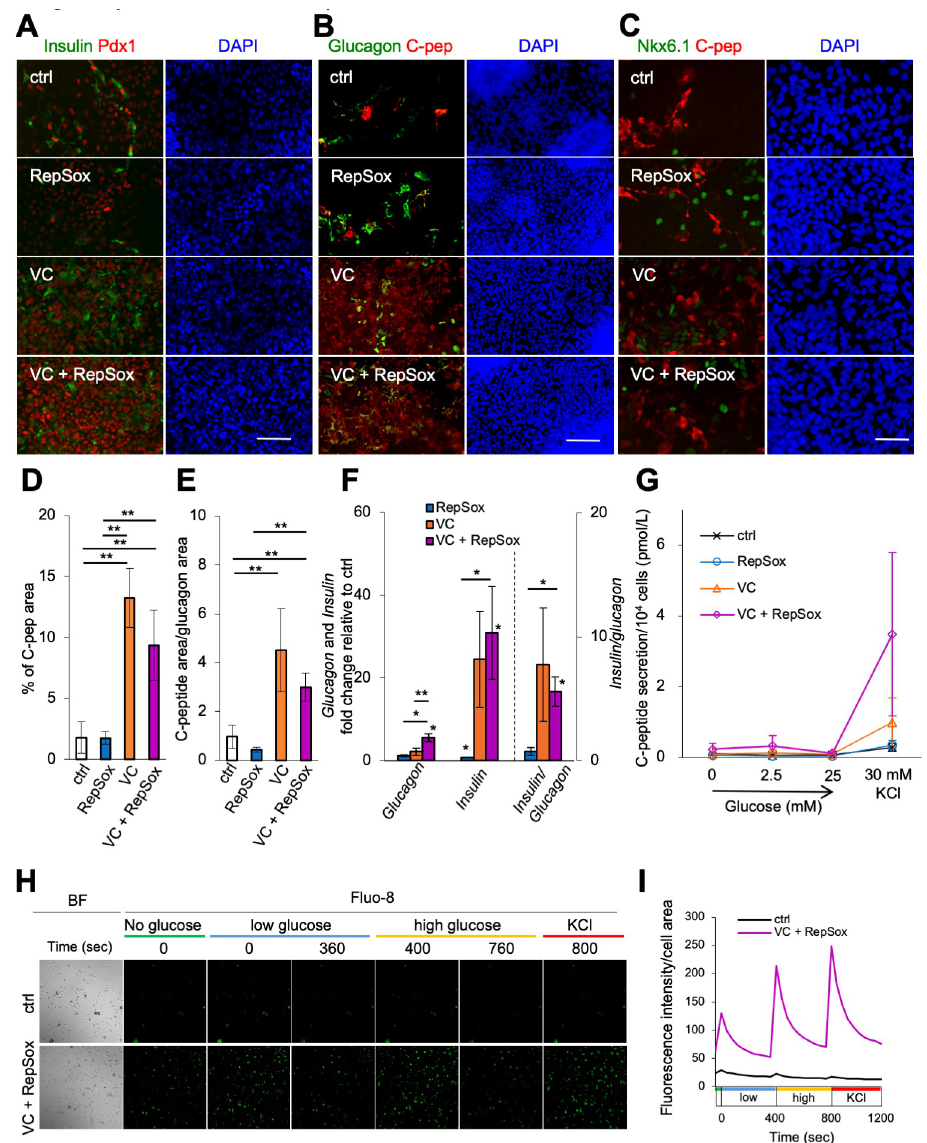
Fig 4. Vitamin C addition increased the number of insulin-producing cells (stage 4). ( A-C ) IHC. The expression of insulin (green) and Pdx1 (red) ( A ). The expression of glucagon (green) and C-peptide (red) ( B ). The expression of Nkx6.1 (green) and C-peptide (red) ( C ). DAPI staining shown in blue. Scale bars: 100 μ m ( A , B ), 50 μ m ( C ). ( D ) The percentage of the cell area expressing C-peptide in the monolayer region, corresponding to B (n = 5, including one biological and five technical replicates). � p < 0.05, �� p < 0.01; Welch’s t -test. ( E ) The C-peptide-positive cell area divided by glucagon-positive area. Glucagon-positive cell areas in a certain region of the monolayer cells were measured using B (n = 5, including one biological and five technical replicates). Control, white; RepSox, blue; VC, orange; VC + RepSox, magenta. � p < 0.05, �� p < 0.01; Welch’s t -test. ( F ) Fold change of the expression levels of the indicated genes and insulin/glucagon compared with the control at stage 4 by qRT-PCR (n = 3 biological replicates per group). RepSox, blue; VC, orange; VC + RepSox, magenta. Asterisks represent statistical significance. � p < 0.05, �� p < 0.01; paired t -test. The asterisk on the bar graph shows a significant difference compared with the control. ( G ) The amount of C-peptide secretion determined by ELISA. Control, black; RepSox, blue; VC, orange; VC + RepSox, magenta. ( H ) Fluorescence image of Fluo-8 staining cells. Ctrl and VC + RepSox treated cells challenged with no glucose, low (2.5 mM) and high (25 mM) glucose and 30 mM KCl. ( I ) Line graphs of the time-course of Ca2+ flux level in control (blue) and VC + RS (orange) treated cells during glucose or KCl